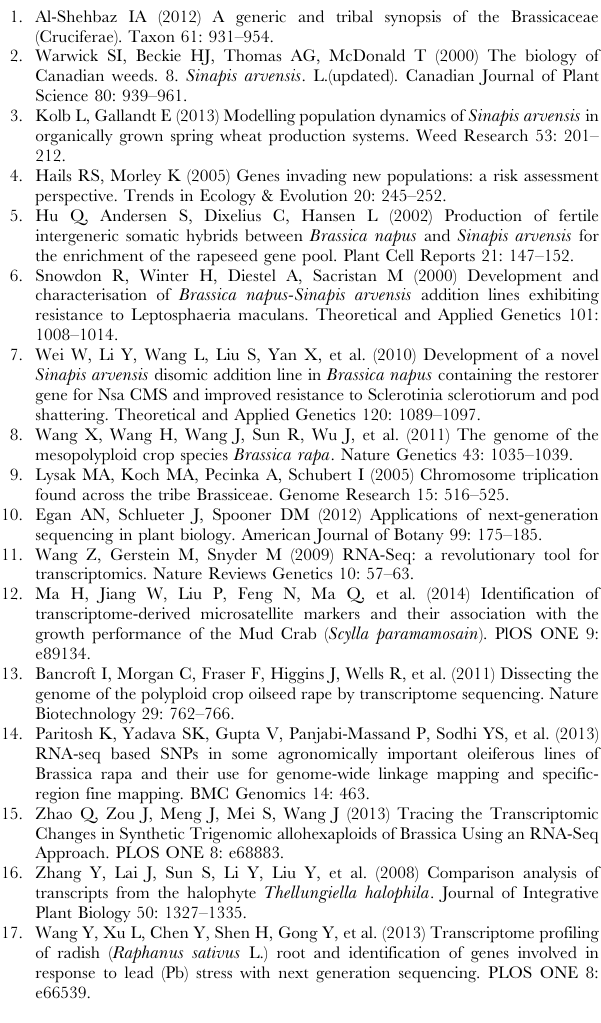
Table S1 KEGG biochemical mappings for S. arvensis . Table S2 Unigenes information of GA Biosynthetic and signal transduction in S. arvensis